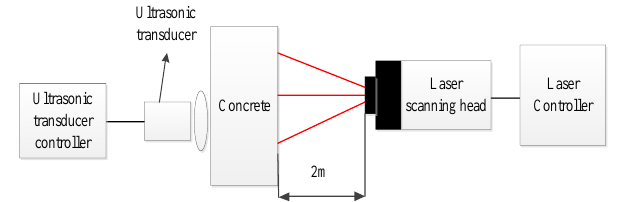
Figure 2. Experimental platform setup.